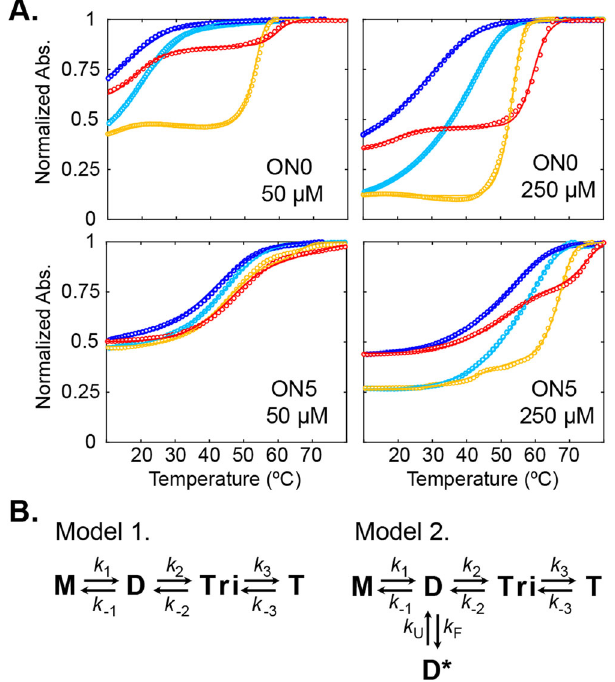
Fig. 6 Modeling ON5 dimeric i-motif formation by thermal hysteresis analysis. A TH traces for ON0 (top) and ON5 (bottom) at 50 μ M (left) 250 μ M (right). Cooling traces are shown in blue (5 °C/min) and cyan (0.5 °C/min). Heating traces are shown in red (5 °C/min) and yellow (0.5 °C/min). Experimental data are shown as points and modeled experiments corresponding to the best- fi t are shown as solid lines. ON0 was fi t to Model 1 and ON5 was fi t to Model 2 shown in B . B Schemes of folding models. Model 1: Sequential tetrameric assembly of monomer (M) into dimer (D), trimer (Tri), and fi nally tetramer (T). Model 2: Sequential tetrameric assembly including an off-pathway dimeric species